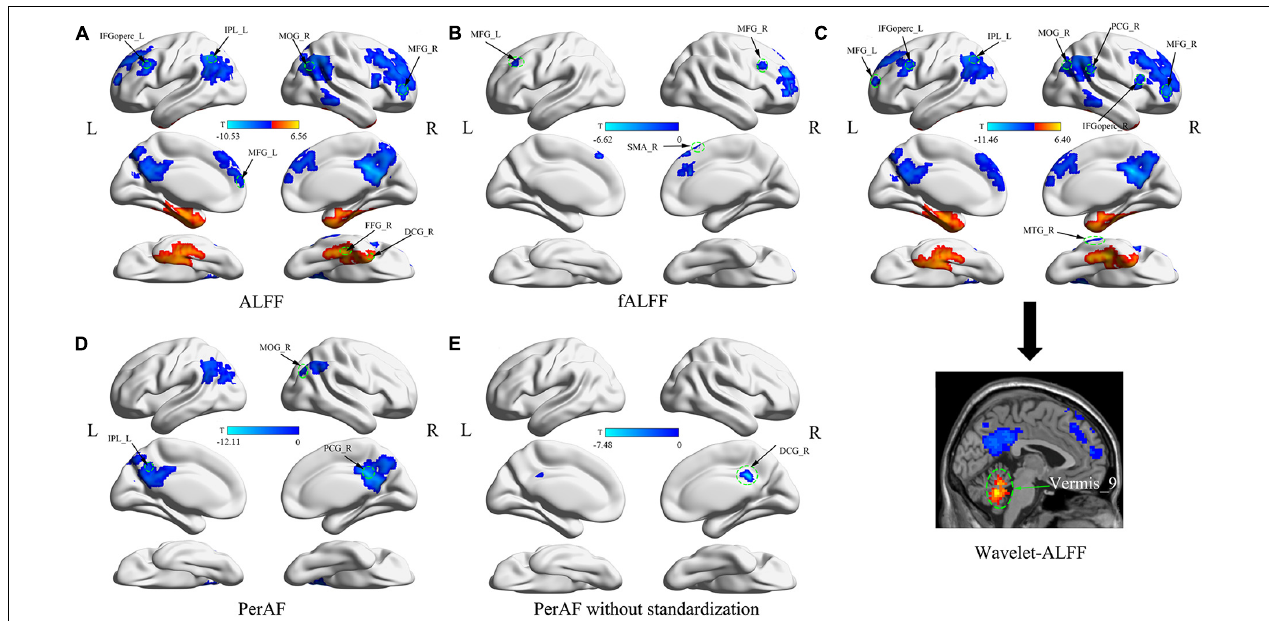
FIGURE 1 | Abnormal brain fluctuations of patients with myotonic dystrophy type 1 (DM1) compared with healthy controls. (A) Differences in ALFFs; (B) Differences in fALFF; (C) Differences in Wavelet-ALFF; (D) Differences in PerAF; (E) Differences in PerAF without standardization. Abbreviations: ALFFs, amplitude of low-frequency fluctuations; fALFFs, fractional amplitude of low-frequency fluctuations; Wavelet-ALFF, wavelet transform-based ALFF; PerAF, percent amplitude of